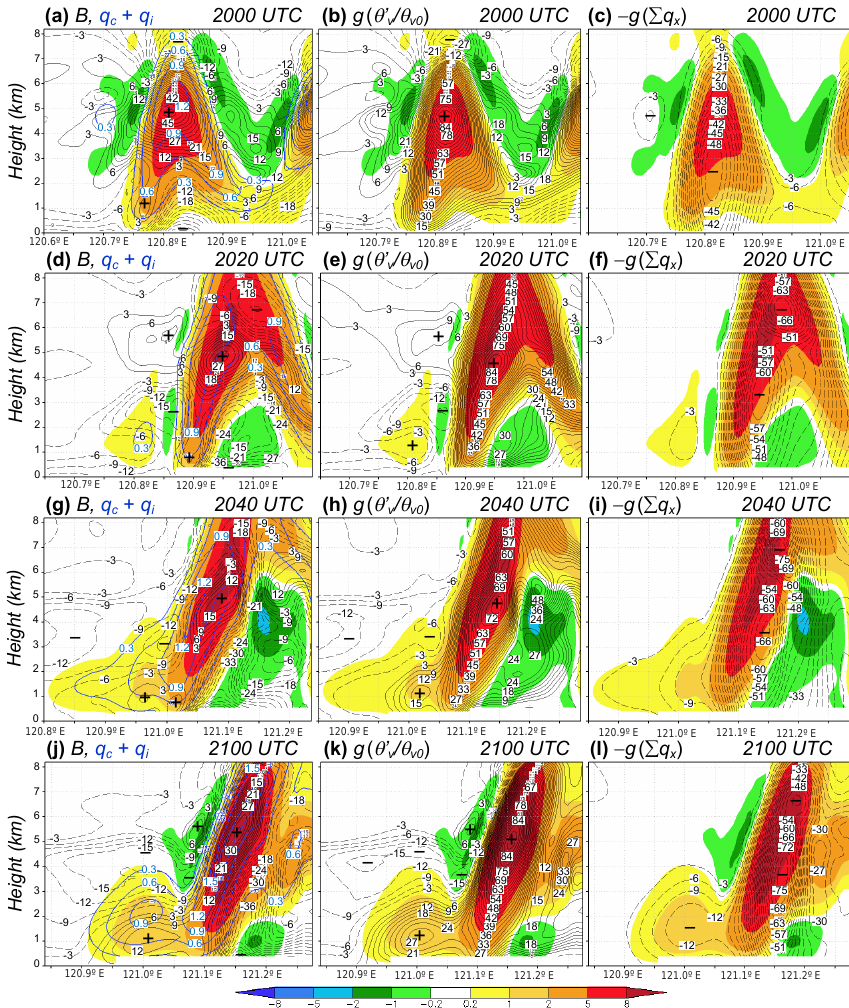
Figure 15. (a–c) As in Fig. 14a–c, but showing w and (a) buoyancy B (10 − 3 ms − 2 , black contour) and mixing ratio of cloud particles (gkg − 1 , blue contour, every 3 gkg − 1 ), (b) g(θ (cid:48) v /θ v0 ) (10 − 3 ms − 2 ), and (c) − g P q x (10 − 3 ms − 2 ). All black contour intervals are 3 × 10 − 6 Pam − 2 (dashed for negative values, zero line omitted), and + ( − ) signs denote upward (downward) maxima. (d–f, g–i, j–l) As in panels (a–c) , except at 20:20, 20:40, and 21:00UTC, respectively.